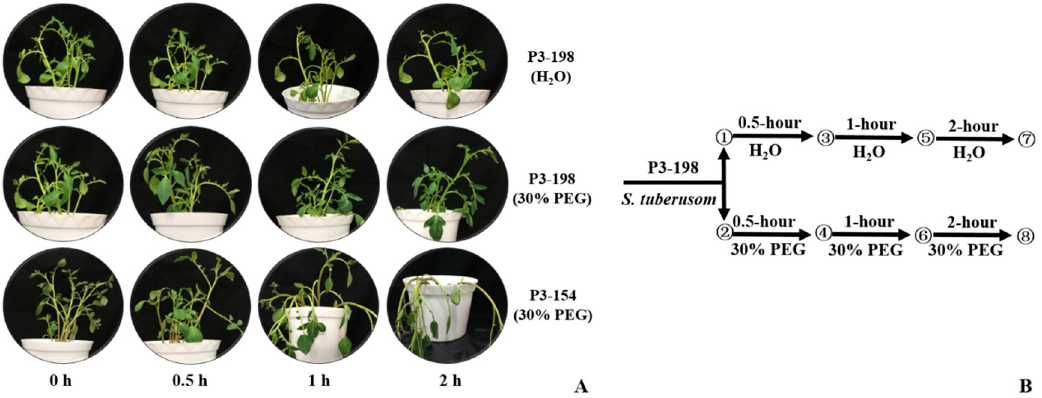
Figure 1. Phenotypes of P3-198 under polyethylene glycol (PEG) stress and well-watered conditions with P3-154 as the sensitive control. ( A ) P3-198 and P3-154 treated with 30% PEG or H 2 O (mock treatment) for 0, 0.5, 1, and 2 h. ( B ) The schematic showing the experimental design and the eight sampling points. Leaves were collected from three plants at each time point, and points ① and ② are the 0 h time points in P3-198.